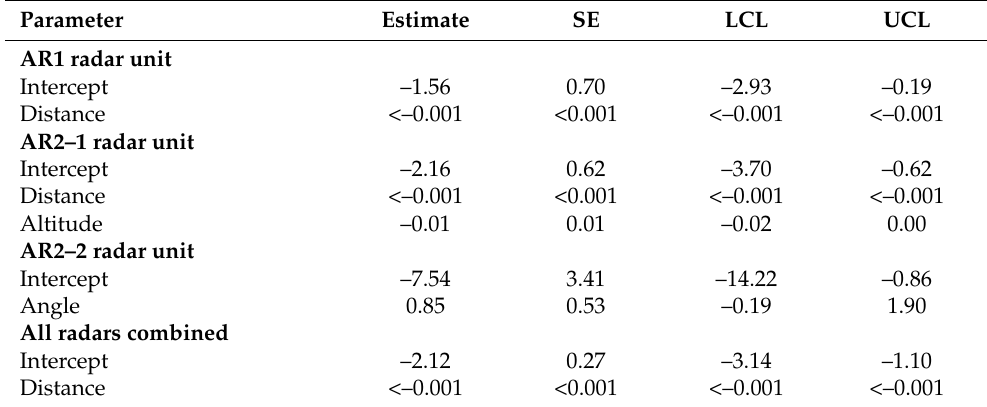
Table 2. Model-averaged parameter estimates with unconditional standard errors (SE) and 95% confidence intervals (LCL, UCL) for radar track (matching) during a study at Chicago’s O’Hare International Airport from September 2010 to May